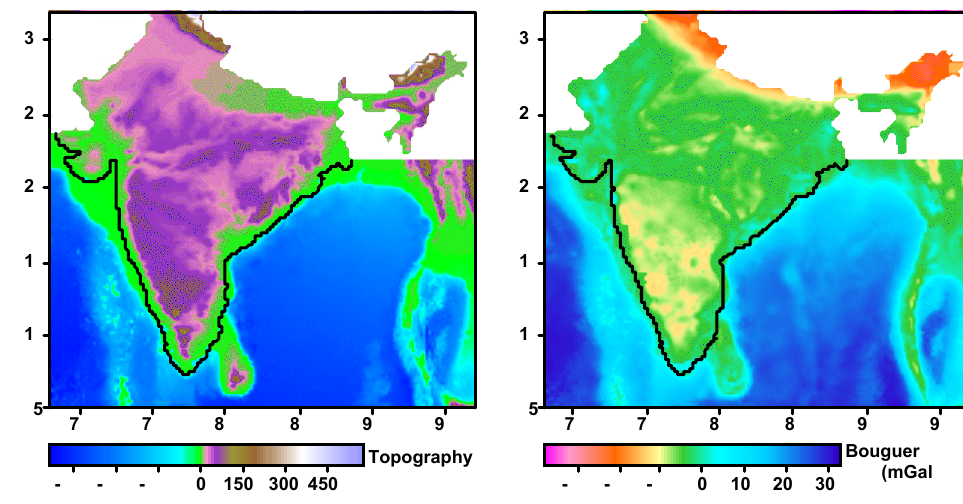
Figure 2. The Indian shield and the adjoining oceanic regions. (a) Topography. (b) Bouguer